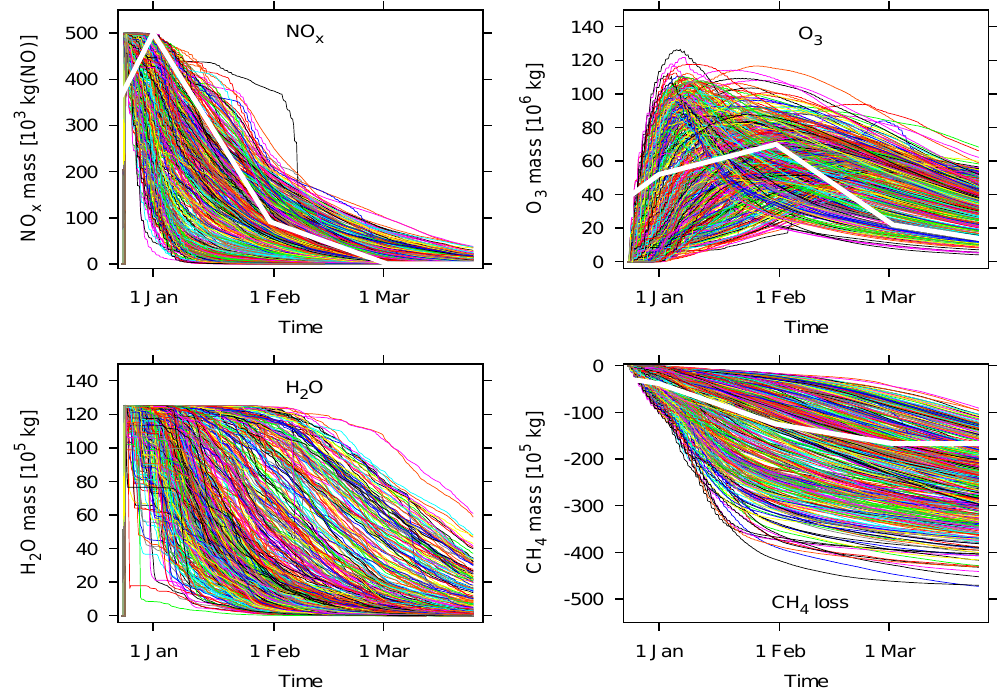
Fig. 9. Temporal evolution of global mean masses of NO x [10 3 kg(NO)], O 3 [10 6 kg], H 2 O [10 5 kg] and CH 4 [10 5 kg]. For every time- region grid point (see Table 2), 50 air parcel trajectories are started and the temporal evolution of the global mean over these 50 air parcel trajectories is presented; that is, each coloured line (in total 504) represents the temporal evolution of species caused by an emission at the respective time-region grid point. The white lines indicate results from Stevenson et al. (2004) scaled by the factor 6 . 94 × 10 − 3 to derive the same initial NO x perturbation. Note that values by Stevenson et al. (2004) are monthly